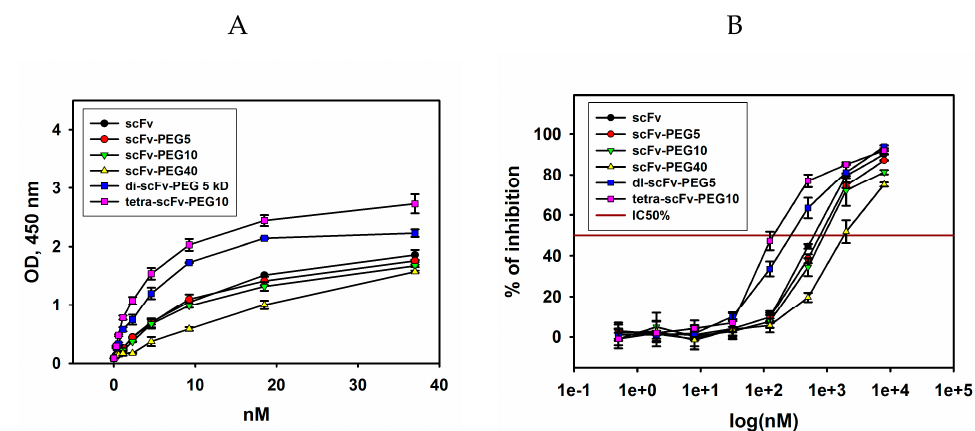
Figure 4. Binding of intact and modified scFv fragments of GD2-specific antibodies with ganglioside GD2. ( A ) direct enzyme-linked immunosorbent assay (ELISA); ganglioside GD2 was adsorbed on the plate, serial dilutions of scFv fragments were added to the wells; after incubation with HRP-labelled anti-FLAG antibodies (1: 6000), the reaction was developed by ultra TMB-ELISA substrate solution. ( B ) competitive ELISA; GD2 was adsorbed on the plate, a mix of biotinylated GD2-specific antibodies 14G2a at a concentration of 50% saturation and different concentrations of scFv fragments was added to the wells; after incubation with HRP-labelled streptavidin (1:6000), the reaction was developed by Ultra TMB-ELISA Substrate Solution. Data are represented as mean ± SEM.